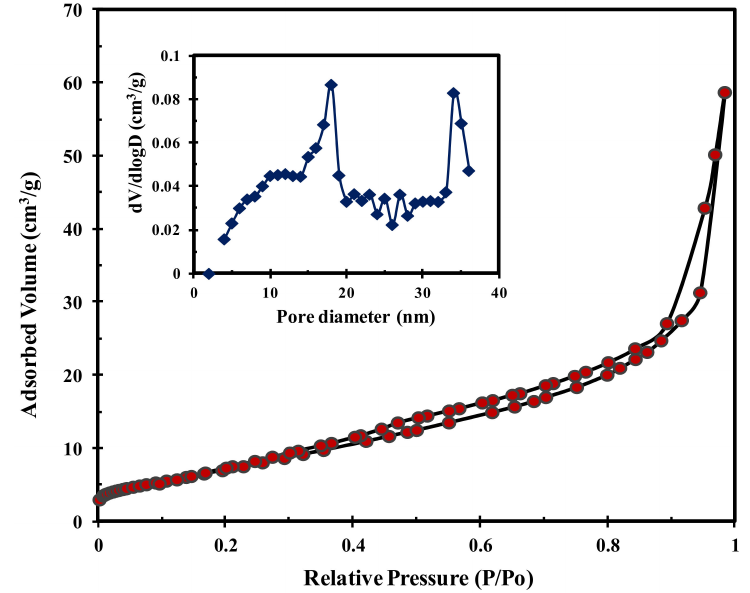
Figure 6. BET and pore size distribution of TPC-SO 3 H